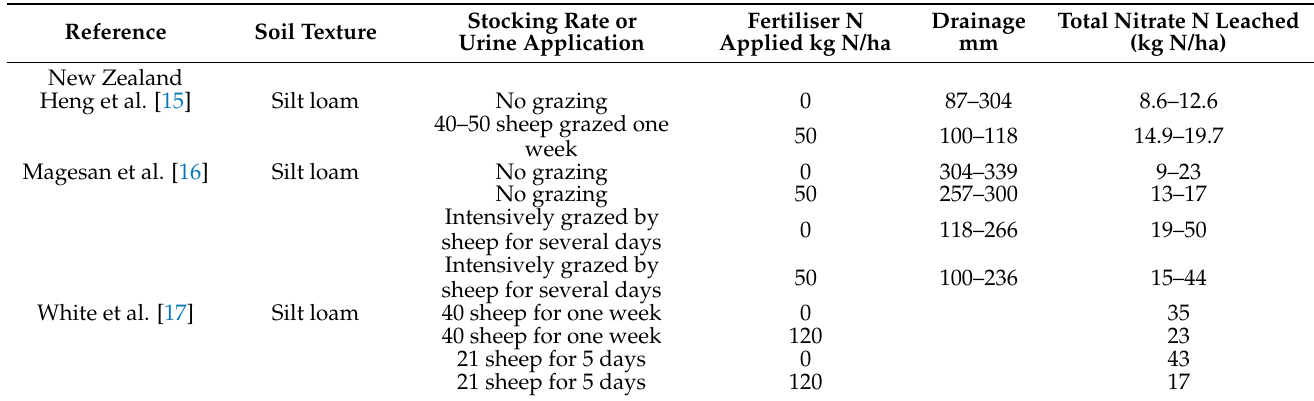
Table 2. Summary of nitrate nitrogen (N) leaching in sheep grazing pasture systems measured using mole and pipe drainage